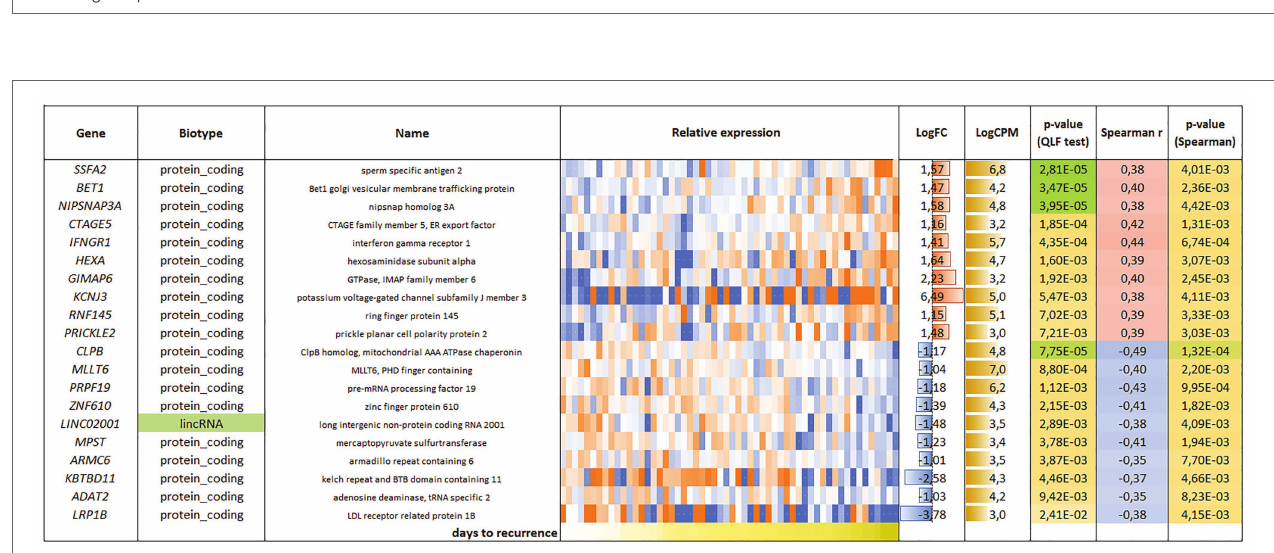
FIGURE 3 | List and heatmap demonstrating log relative expression level of genes with significant Spearman’s rank correlation coefficient relative to PFS for LAPC. Cell colors (blue-white-orange gradient) correspond to the binary logarithm of the ratio of the expression level in a current sample to the average level across all the samples (per each gene). Blue – expression level is below the average, orange – above the average. LogFC – binary logarithm of the ratio of GLM-approximated expression values between samples with maximal and minimal PFS; LogCPM – binary logarithm of read counts per million (CPM); p -value (QLF test) – p -value according to quasi-likelihood F-test (edgeR); Spearman r – Spearman’s rank correlation coefficient between gene expression level and PFS; p -value (Spearman) – p -value according to Spearman’s rank correlation test.